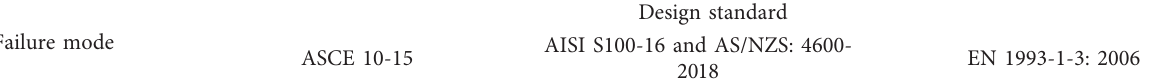
Table 5: Salient features of design